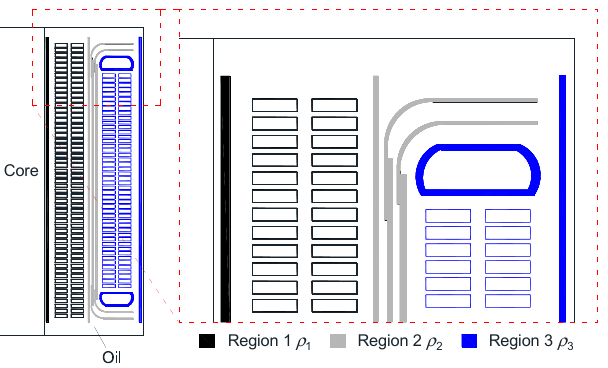
Figure 12. Region division of paper.